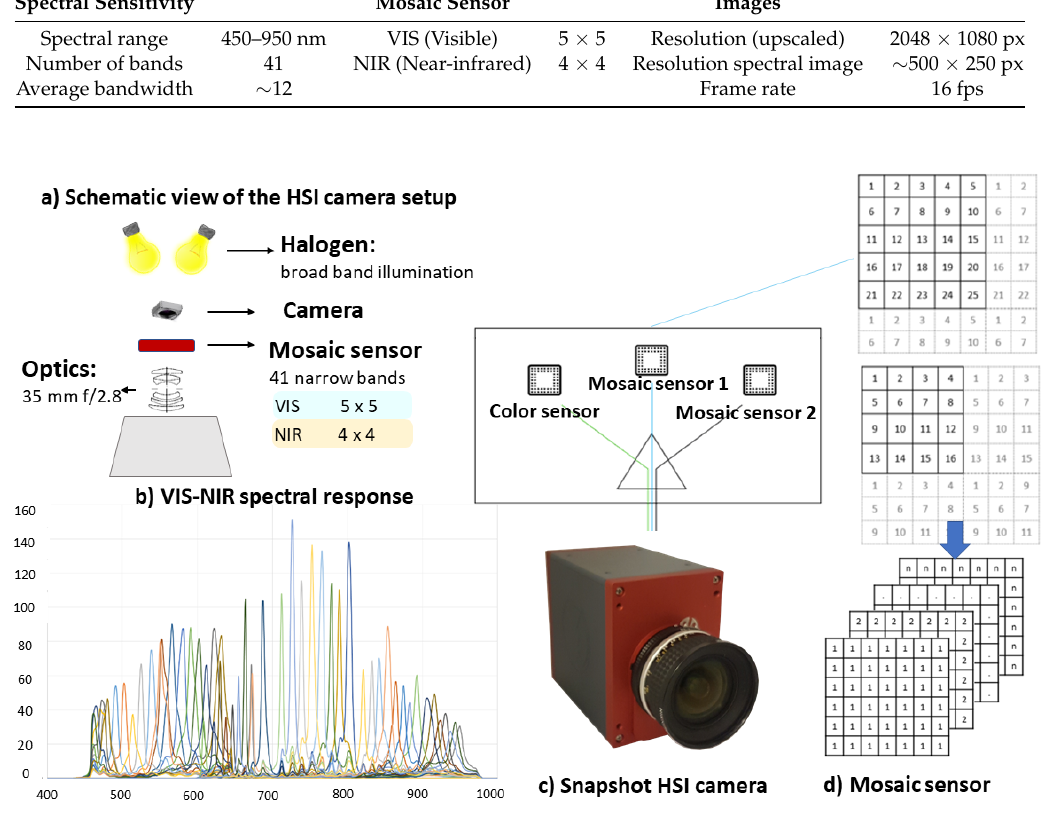
Figure 2. ( a ) Schematic view of the hyperspectral imaging (HSI) camera setup. ( b ) Plot of the spectral response of the camera, where the different lines correspond to the individual channel responses. Similar to an RGB camera with three filters for each color pixel, in a snapshot HS camera, each sensor is composed of several pixels that are responsive for a wavelength in the band spectrum. ( c ) Experimental prototype of the snapshot HSI camera. ( d ) Mosaic sensor technology. The picture describes a tiled-filter approach where different wavelengths are captured for different cavity